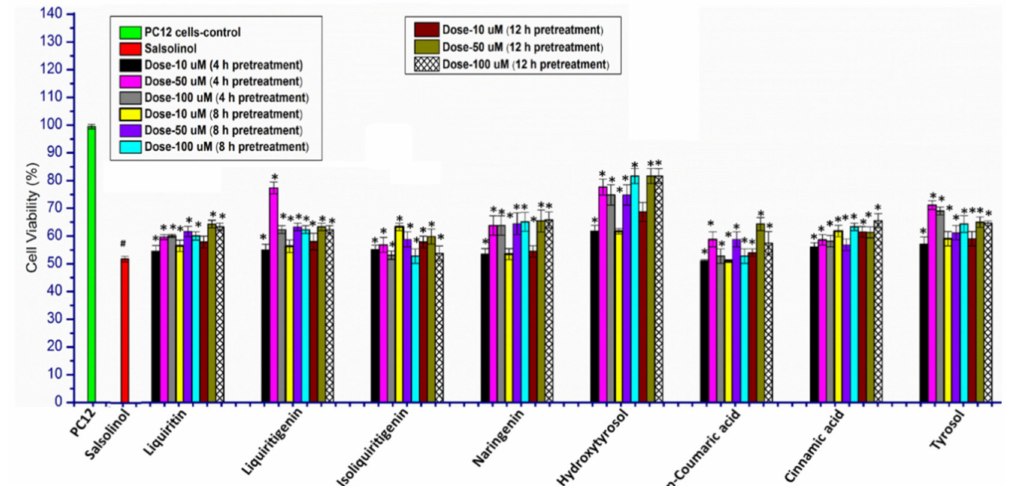
Figure 1. Comparative antioxidant activity of flavonoids measured via MTS assay. The comparative dose and time course-dependent antioxidant activity of liquiritin, liquiritigenin, isoliquiritigenin, naringenin, hydroxytyrosol, p-Coumaric acid, cinnamic acid, and tyrosol were determined for PC12 cells. Hydroxytyrosol demonstrated the strongest antioxidant activity compared to the other antioxidants. Data are mean and S.E. values from three independent experiments ( n = 3). p < 0.01, relative to